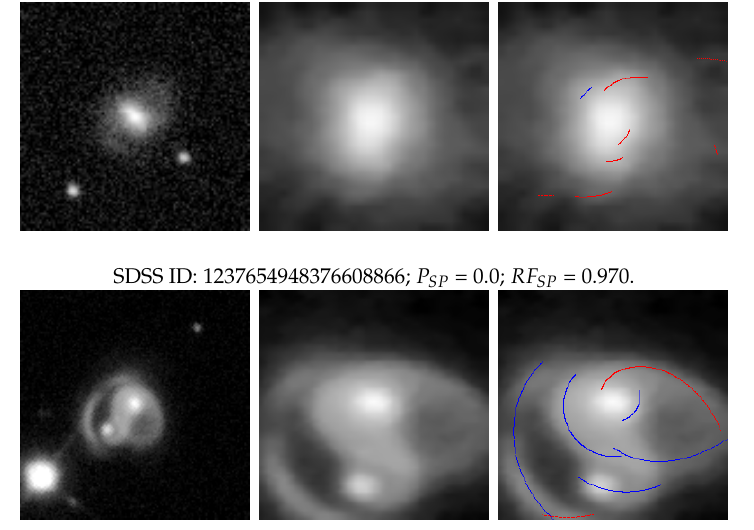
Figure 7. Grossly Misclassified Objects. In sets of 3, from left to right column, the images show the Original Input Image, the same image automatically cropped by SpArcFiRe, and the spiral Arcs detected on the image (if any). The SDSS Object IDs, the GZ1 Spirality prediction ( P SP ), and our Random Forest Prediction ( RF SP ) are shown above each trio of images. In all but the last, the problem is low-surface-brightness arms, which we know about and are working on this issue. Despite the disagreement in the 5th object, a merger, spiral structure is indeed